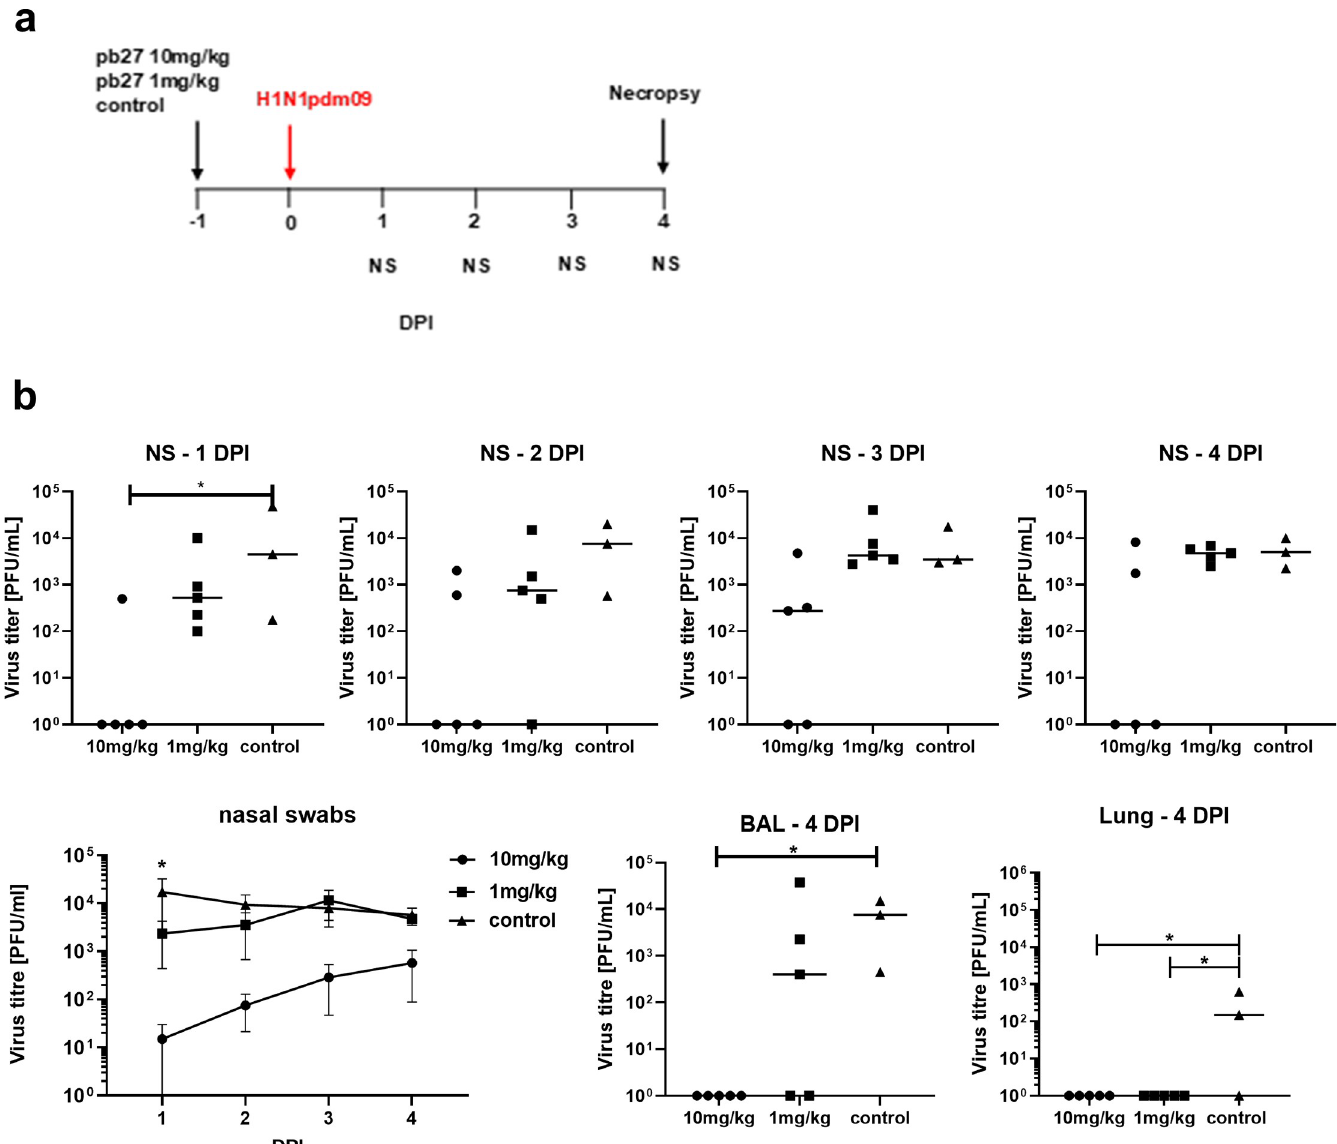
Fig 6. In vivo efficacy of pb27. pb27 was administered intravenously to pigs at 10 mg/kg and 1mg/kg, which were infected with H1N1pdm09 virus 24 hours later. Only three control animals were available. Nasal swabs (NS) were taken daily post-infection (DPI) and pigs euthanized at 4 DPI ( a ). Virus titers in NS, accessory lung lobe (Lung) and BAL at 4DPI were determined by plaque assay ( b ). Each data point represents an individual pig within the indicated group and bars show the mean. Virus shedding in NS is also represented as the mean of the 5 pigs on each day and significance versus diluent control indicated by asterisks. Virus titers were analysed using one-way non-parametric ANOVA, the Kruskal-Wallis test. Asterisks denote significant differences � p < 0.05 versus control.